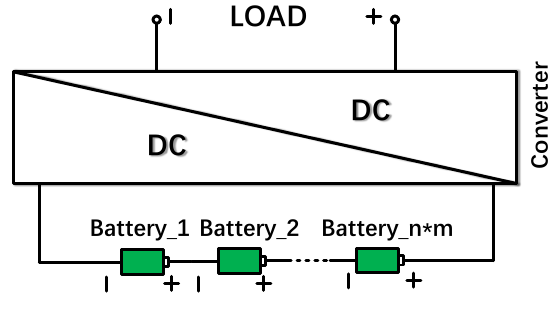
Figure 8. Ideal circuit.